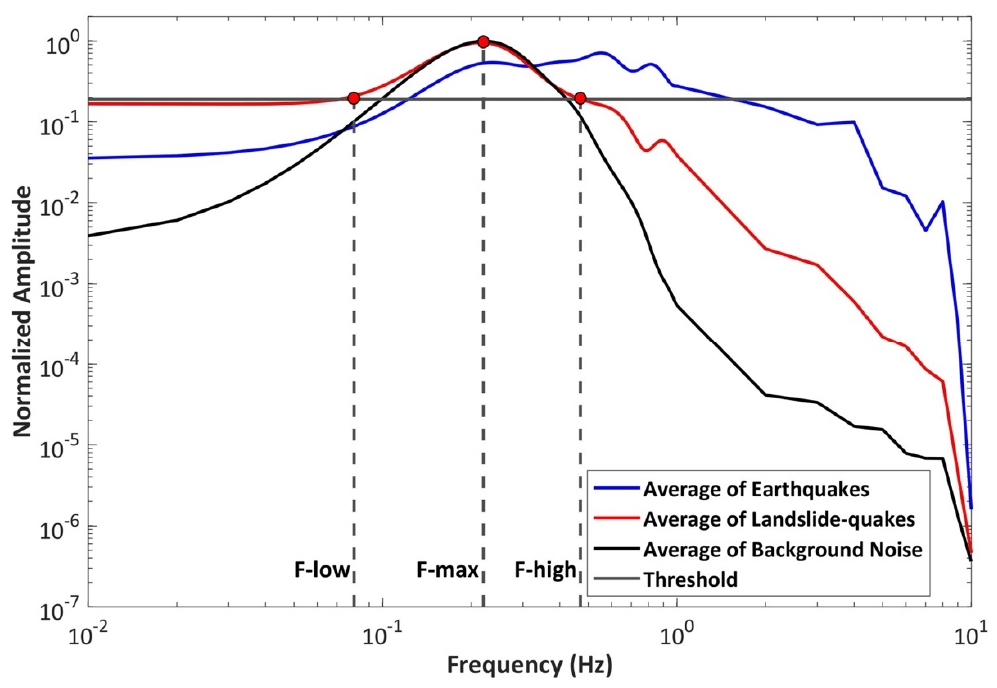
Figure 6. Average spectra of 30 seismic signals induced by 10 landslide-quakes, 10 earthquakes, and 10 noise signals. All seismograms are taken from the vertical components of the stations listed in Figure 1.